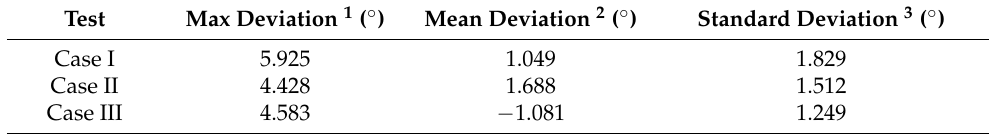
Table 6. Table of heading deviation related